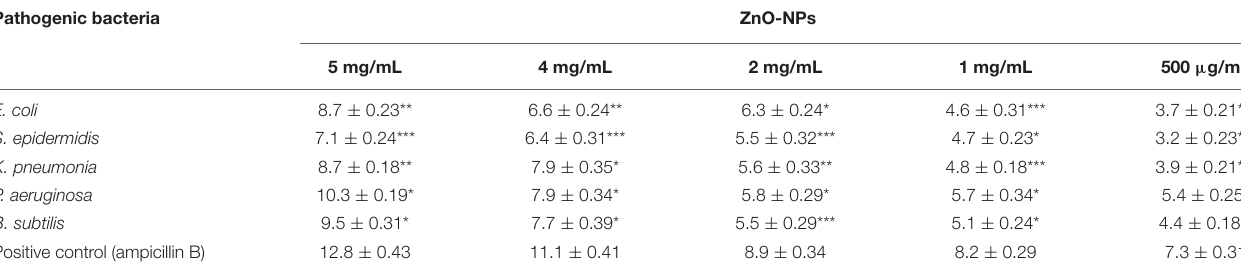
TABLE 3 | Antibacterial activity of ZnO-NPs against pathogenic bacterial strains. Pathogenic